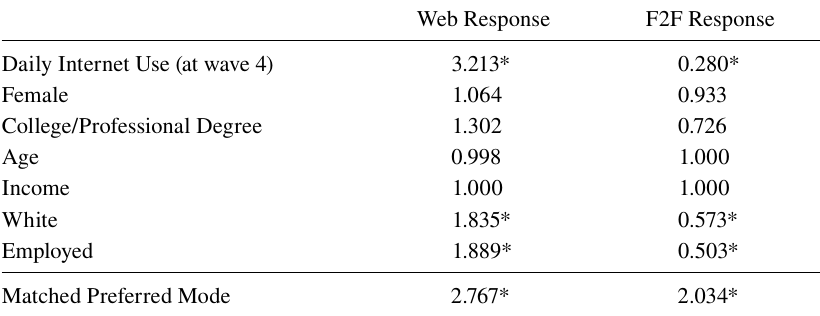
Table 6 Odds Ratios for Mode of Response at IP Fifth Wave